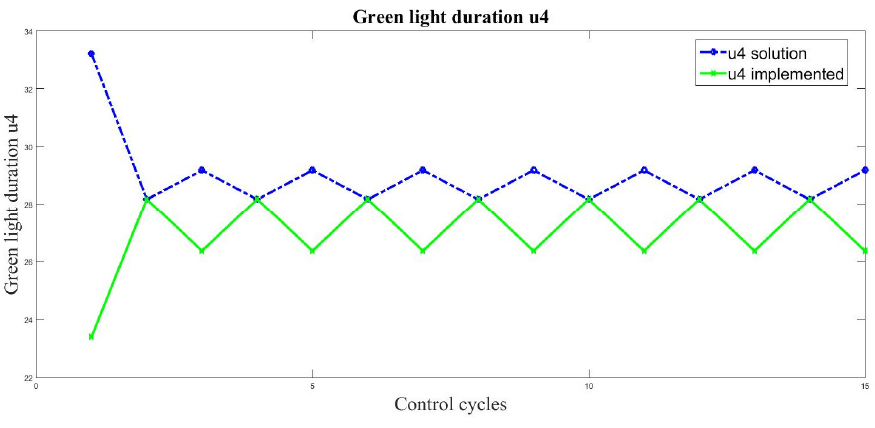
Figure 7. Difference between the evaluated and implemented green light duration u 4 .